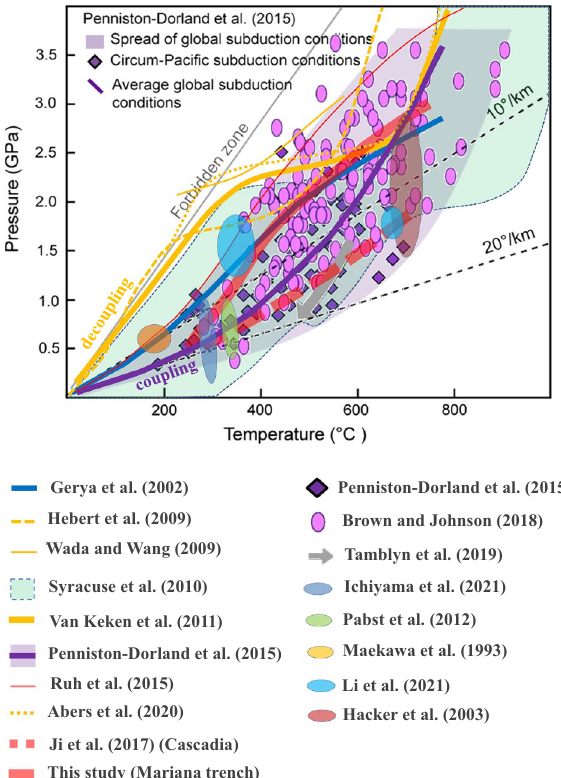
Figure 6. Comparison of the subduction P–T conditions between this study (thick red curve), previous thermal models (other colored curves) and the observations of exhumed rocks (colored ellipses, diamonds and arrows). Our temperature results (thick red curve) are higher than those of Wada and Wang 9 (yellow thin line) and other cold-type model results 68–70 by 200–300 °C but compare well with the P ‒ T conditions of observations of other thermal models 10,61 , exhumed rocks 63,64 , and other rock evidence (colored